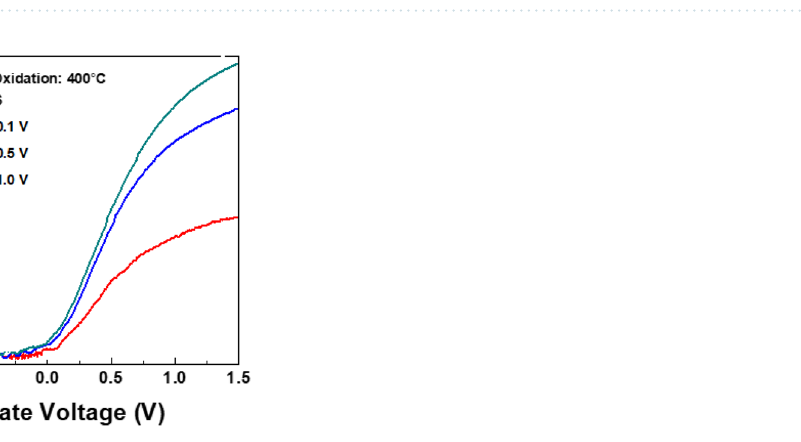
Figure 4. HR-TEM images and EDS of the interface between the gate metal and IGZO for various annealing temperatures.